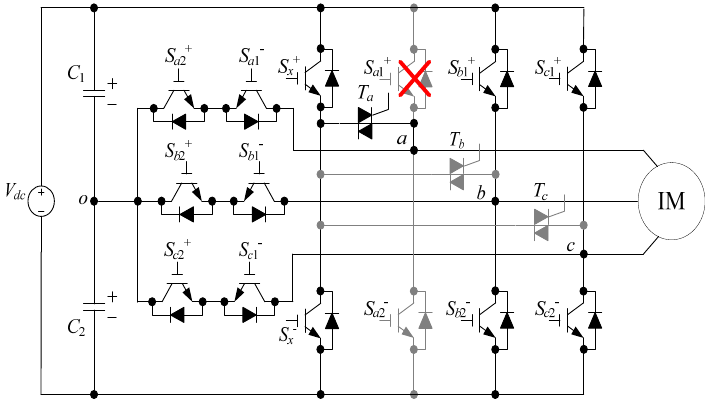
Figure 10. Tolerant control state when an open-circuit fault occurs in inverter switch S a 1+ .